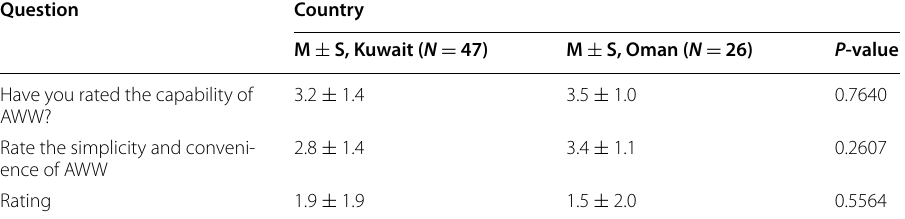
Table 4 Comparison of quantitative variables by country code Question Country